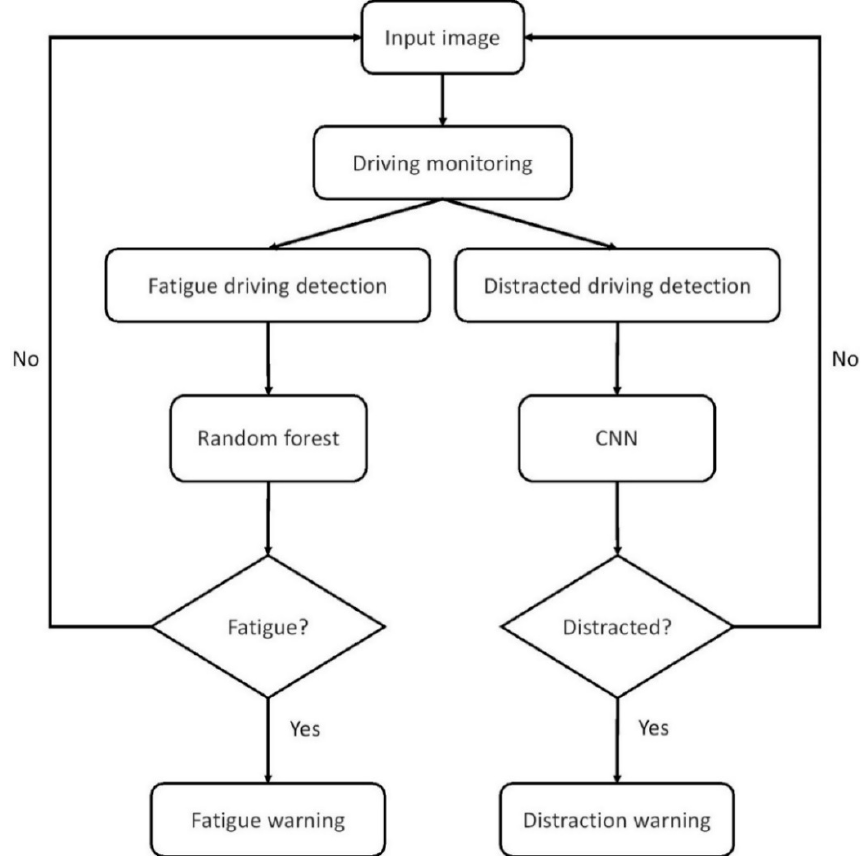
Figure 1. Flowchart of the proposed approach for detecting driver fatigue and distracted driving.